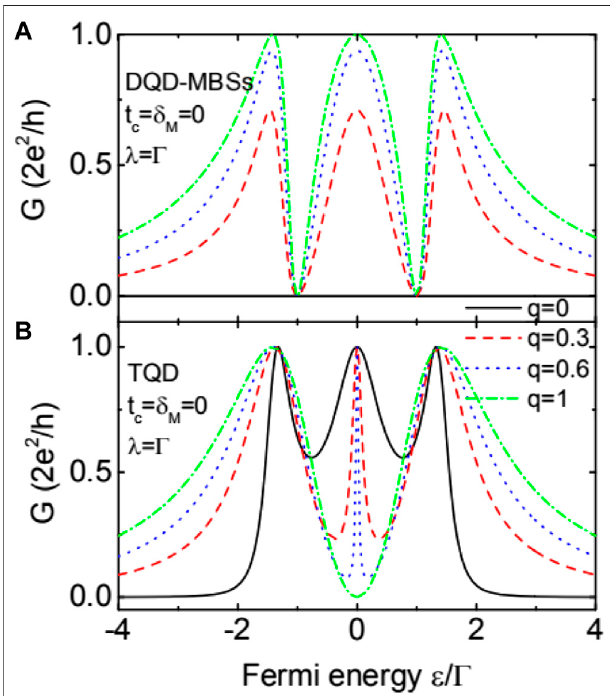
FIGURE 3 | Dependence of the linear conductance on the Fermi energy for the case of the double QDs are coupled to each other by the MBSs (DQD- MBSs) in (A) and the case of the two QDs connected by regular fermions, i.e., another QD in (B) . The latter corresponds to the triple-QD (TQD) con fi guration.